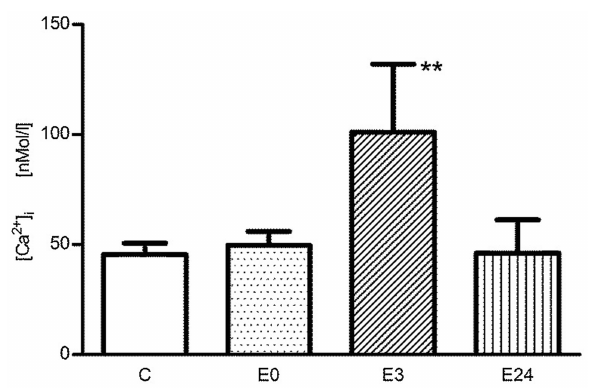
FIGURE 1 | The change of basal [Ca 2+ ] i of murine splenic T lymphocytes in the control group (C), immediately after (E0), 3 h after (E3), and 24 h (E24) after acute exercise. Data are presented as means ± SEM. ** p < 0.01 vs.